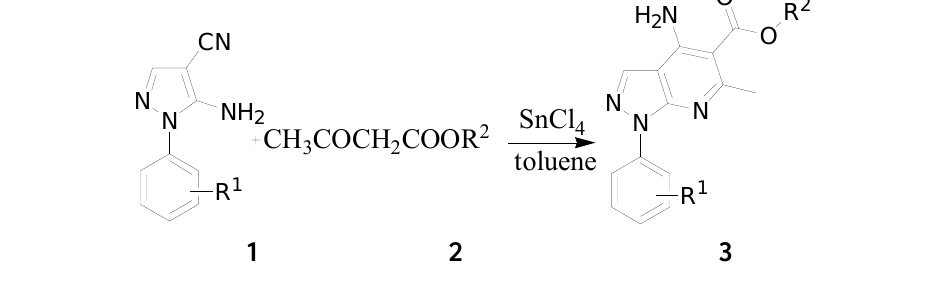
Table 1. Effect of the catalyst on the yields .